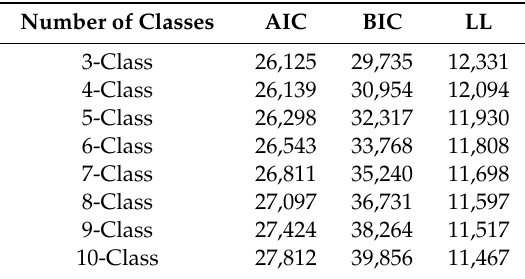
Table 3. Model fit